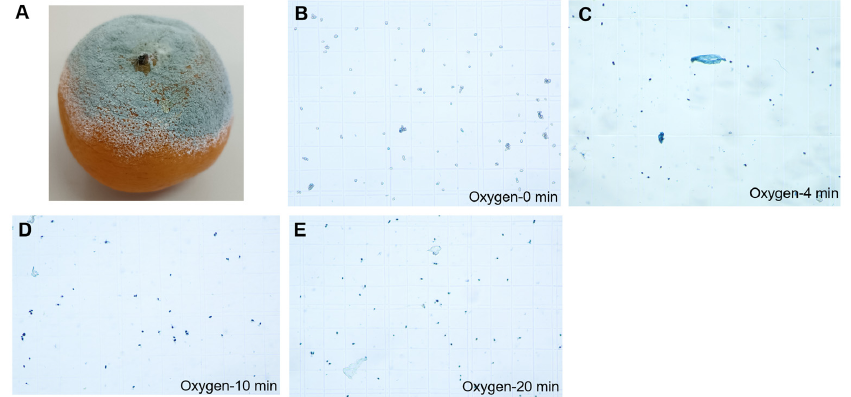
Figure 4. Effect of treatment with low-temperature plasma (oxygen ionization) on pathogenic spores. Appearance of a rotten fruit ( A ). Appearance of stained spores after 0 min ( B ), 4 min ( C ), 10 min ( D ), and 20 min ( E ) of low-temperature plasma treatment. Pathogenic spores were dyed with trypan blue.